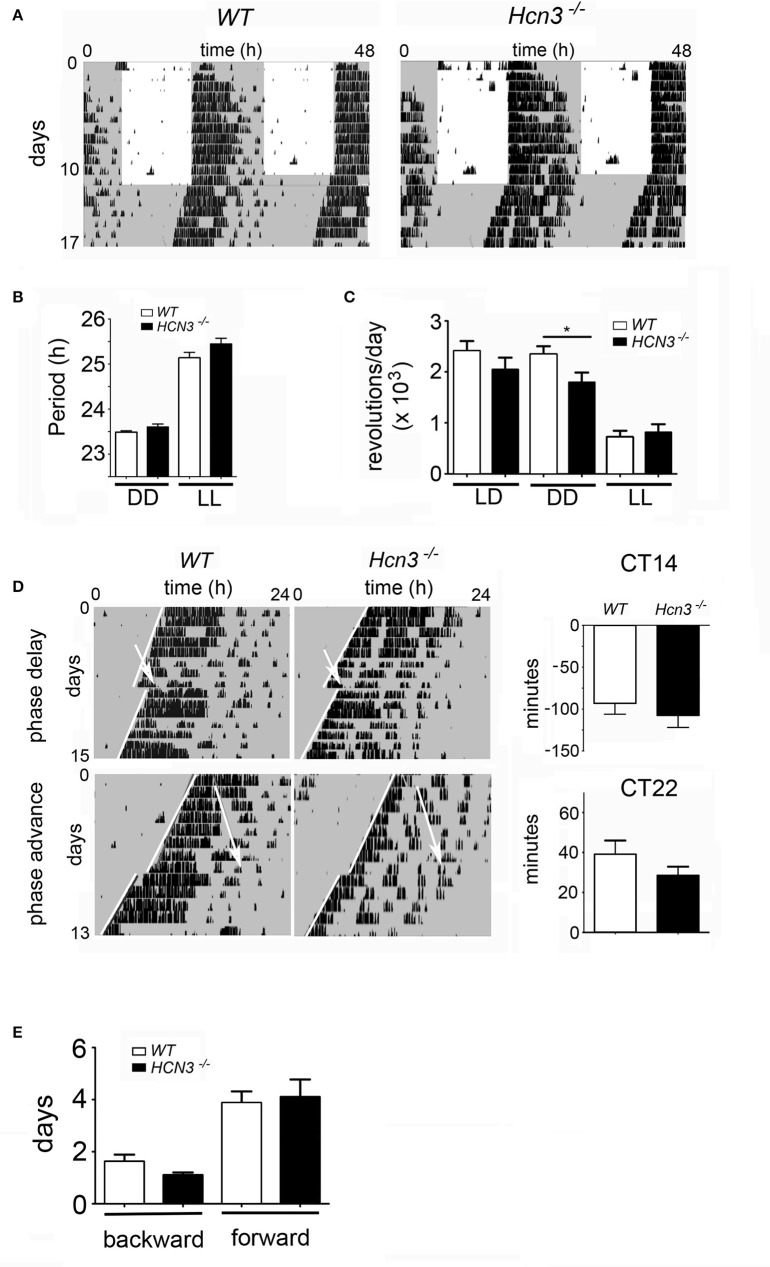
Circadian clock parameters of HCN3−/− mice. (A) Wheel-running activity of wild type (left) and HCN3−/− (right) mice. Gray areas indicate darkness and white areas light. The actograms are double plotted and display two consecutive days per line. (B) Quantification of the period under constant darkness (DD) and constant light (LL) of wild type (black bars) and HCN3−/− (white bars) mice. Under DD conditions the periods were 23.49 ± 0.03 h (n = 7) and 23.6 ± 0.07 h (n = 9) and under LL conditions they were 25.14 ± 0.12 h (n = 7) and 25.45 ± 0.13 h (n = 9), respectively. (C) Total activity in the two genotypes under light dark (LD), DD, and LL conditions. Wheel revolutions (rev) per day were counted and were as follows: LD conditions, WT 24091 ± 1960 rev (n = 8), HCN3−/− 20439 ± 2357 rev (n = 10), DD conditions, WT 23482 ± 1555 rev (n = 8), HCN3−/− 17925 ± 1945 rev (n = 10), LL conditions, WT 7200 ± 1241 rev (n = 8), HCN3−/− 8118 ± 1613 rev (n = 10). (D) Clock-resetting in response to a light pulse at CT14 (phase delay) and CT22 (phase advance). White arrows indicate the time of application of the light pulse. White lines delineate activity onset, before (top) and after (bottom) the light pulse. The phase delays were: WT −93.29 ± 12.88 min (n = 7) and HCN3−/− −107.8 ± 14.24 min (n = 10). The phase advances were: WT 39 ± 7.01 min (n = 5) and HCN3−/− 28.44 ± 4.45 min (n = 9). (E) Adaptation time to a jet-lag delaying the onset of light by 6 h (backward shift) or advancing the onset of light by 6 h (forward shift). The adaptation times were: backward, WT 1.63 ± 0.26 days (n = 8) and HCN3−/− 1.1 ± 0.1 days (n = 10), forward, WT 3.88 ± 0.44 days (n = 8) and HCN3−/− 4.1 ± 0.67 days (n = 10). All values are Mean ± SEM, unpaired two-tailed t-test, *p < 0.05.